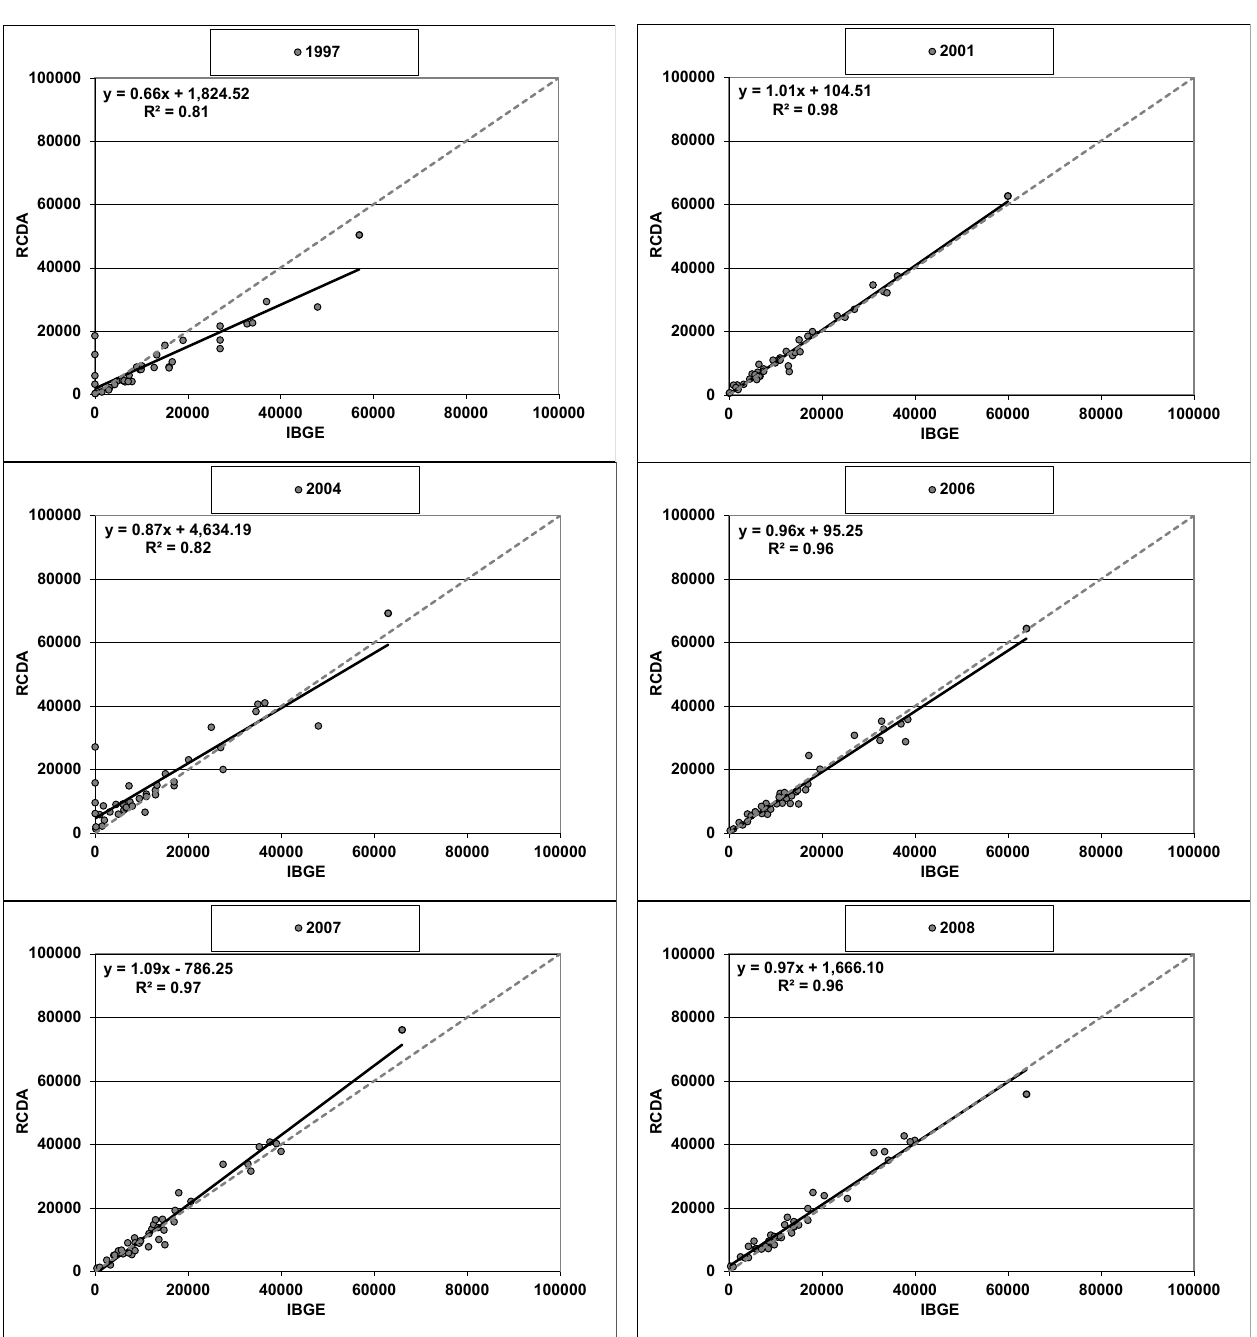
Figure 6. Scatterplot diagram and regression analysis, of soybean area estimates, between RCDA and IBGE municipalities for each of the selected crop years through 1996/1997 to